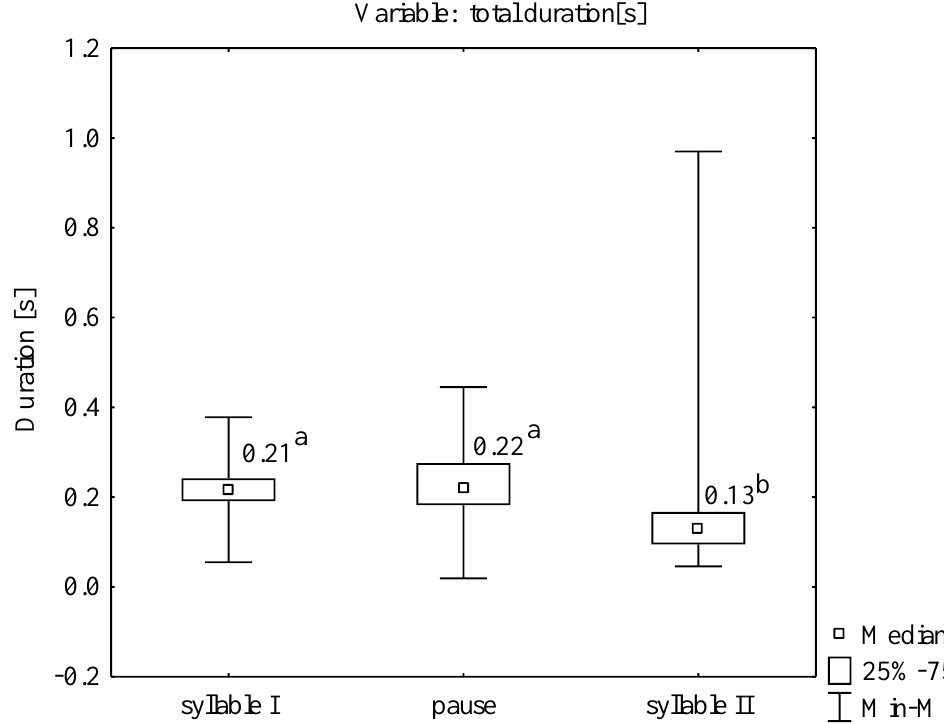
Figure 3. The distribution of the duration of individual elements of vocalization. The variables marked with different letters differ significantly at p < 0.05; (Kruskal-Wallis ANOVA, multiple comparison test).